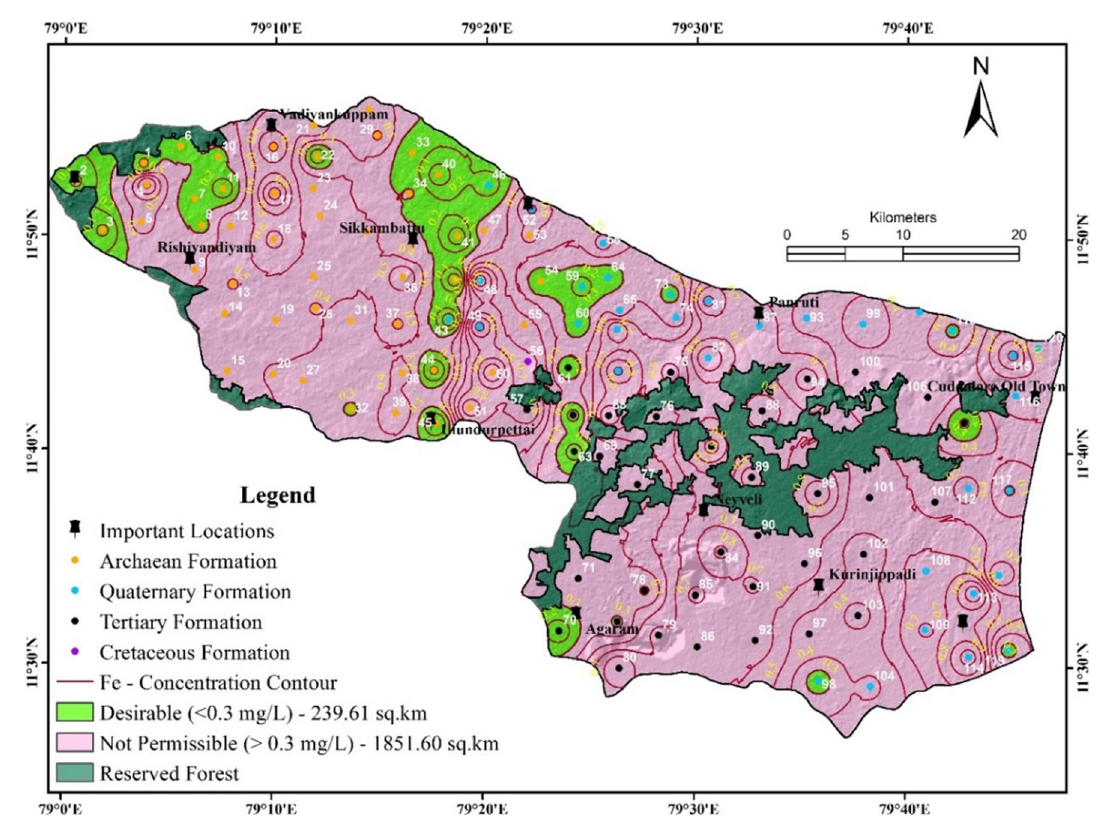
Fig. 11 Spatial variation with contour map of iron in